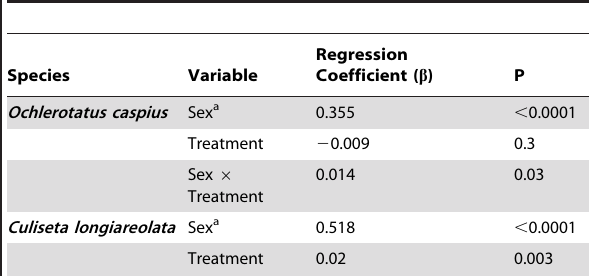
Table 4. The response of adult size to sex, treatment, and larval development